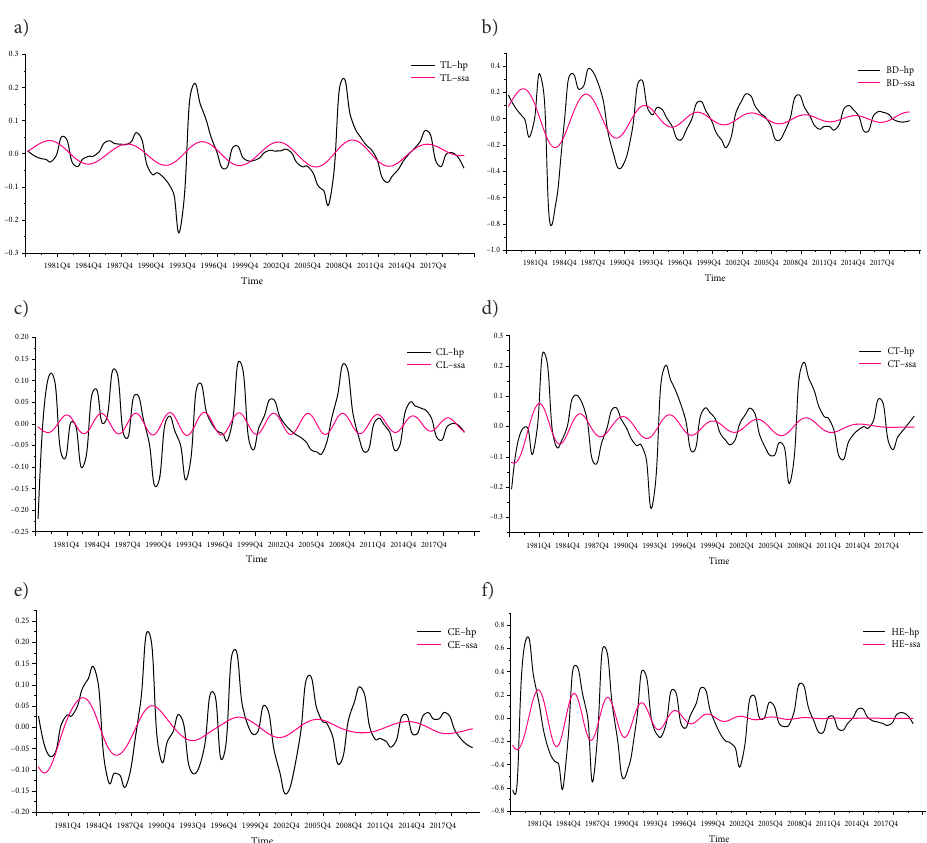
Figure 5. Selected financial cycles in financial research of China (source: authors’